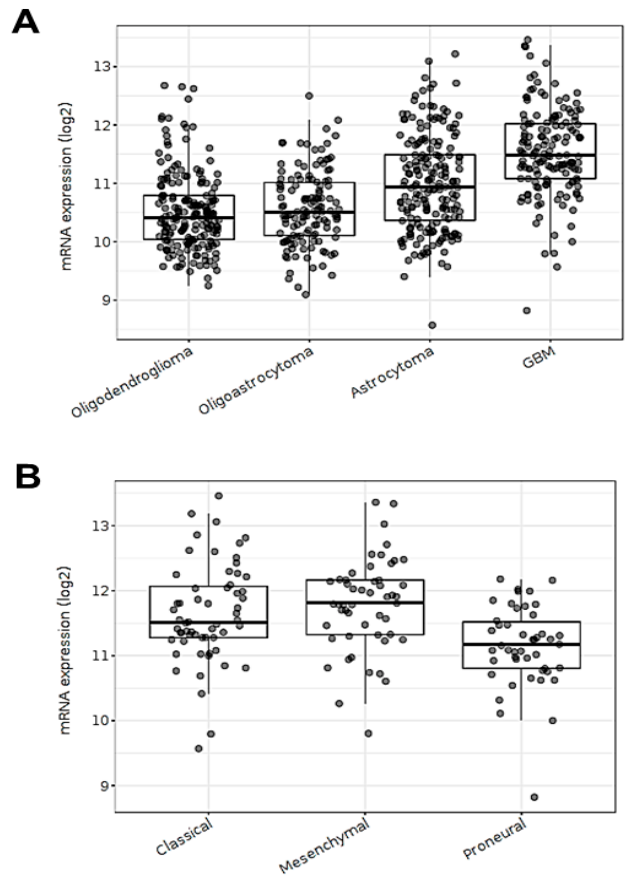
Figure 1. ECE1 mRNA levels are associated with highly aggressive gliomas. ( A ) ECE1 mRNA levels according to glioma grade (oligodendroglioma ( n = 191), oligoastrocytoma ( n = 130), and astrocytoma ( n = 194)) and GBM ( n = 152). ( B ) ECE1 mRNA levels according to subtypes of GBM. The samples were classified as classical ( n = 59), mesenchymal ( n = 51), and proneural ( n = 46) subtypes. Glioma samples were obtained from The Cancer Genome Atlas (TCGA) RNA-seq database and analyzed using GlioVis accessed on 18 April 2021 (http://gliovis.bioinfo.cnio.es/) [36]. In total, 667 glioma samples were selected to analyze the differential ECE1 mRNA levels of low-grade gliomas and GBM. The GBM samples were selected to analyze the differential ECE1 mRNA levels of the GBM subtypes.